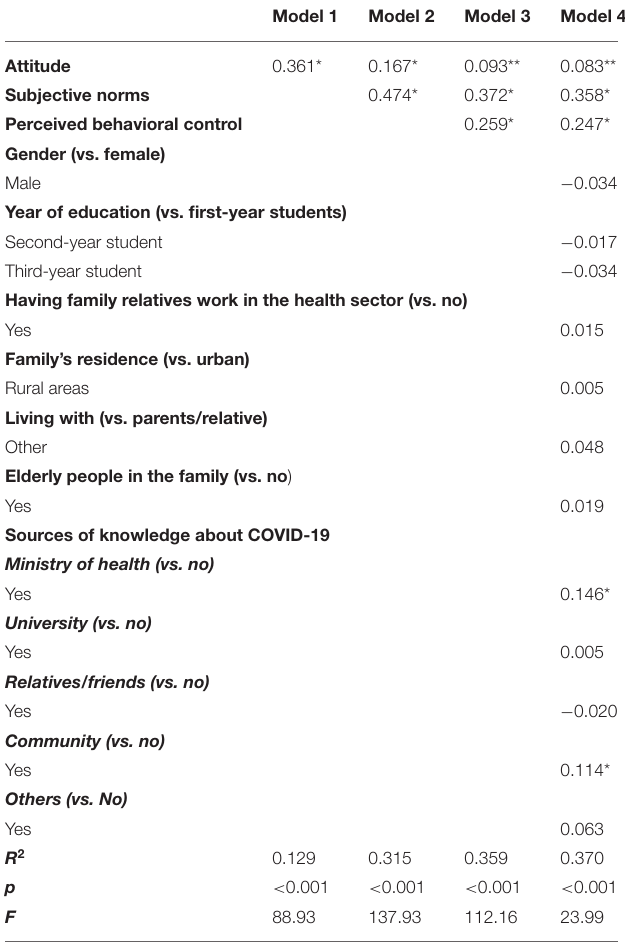
TABLE 4 | Hierarchical linear regression of study